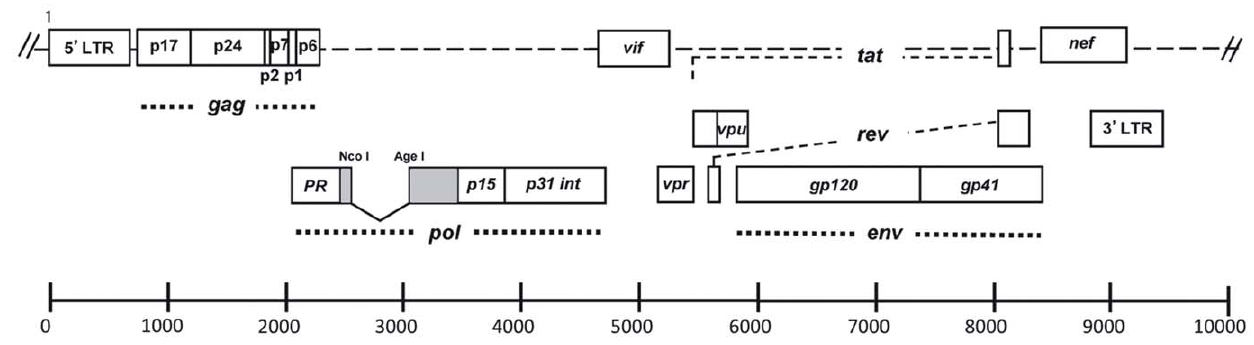
Figure 1. NL4-3/ D RT plasmid graphic scheme. NL4-3 (WT) plasmid was used to generate the NL4-3/ D RT plasmid by deleting an 892 bp fragment, which codes for the retrotranscriptase (RT) and is inside the pol gene. These plasmids were used to transfect 293-T cells in order to obtain viruses. Numbers refer to pNL4-3.